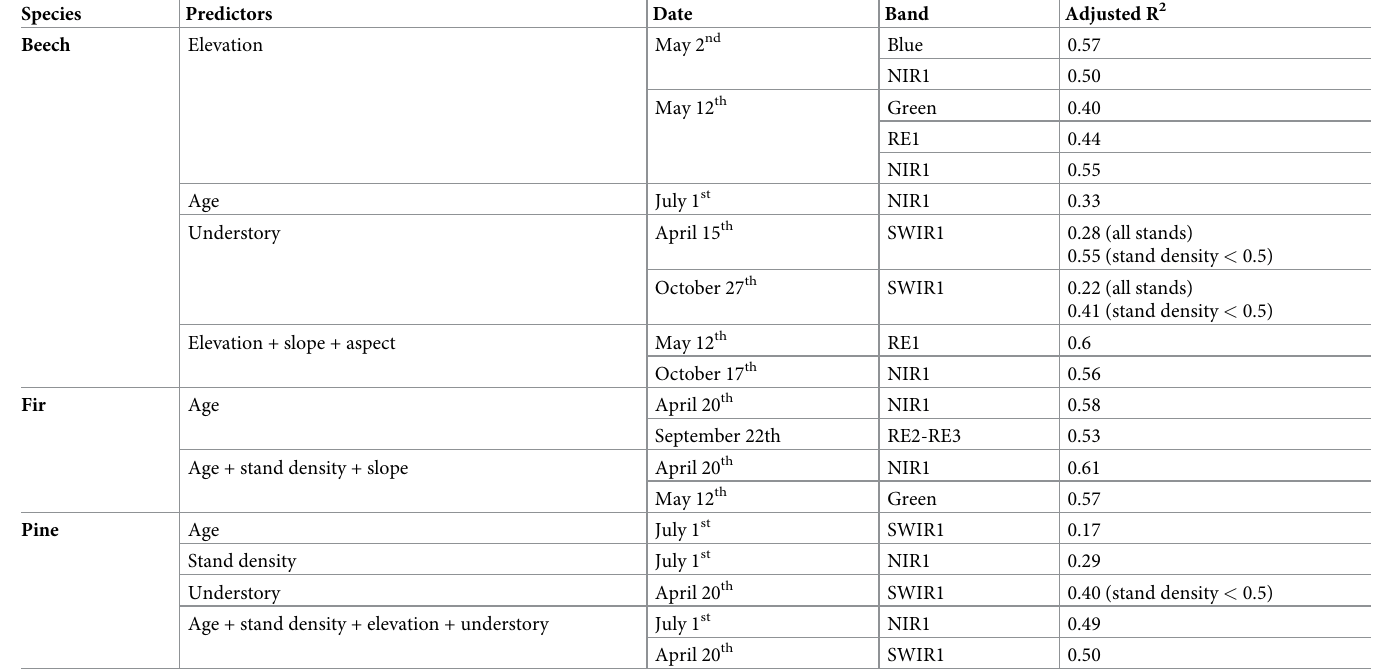
Table 3. Selected adjusted R 2 values for the GAMs regression for three examined